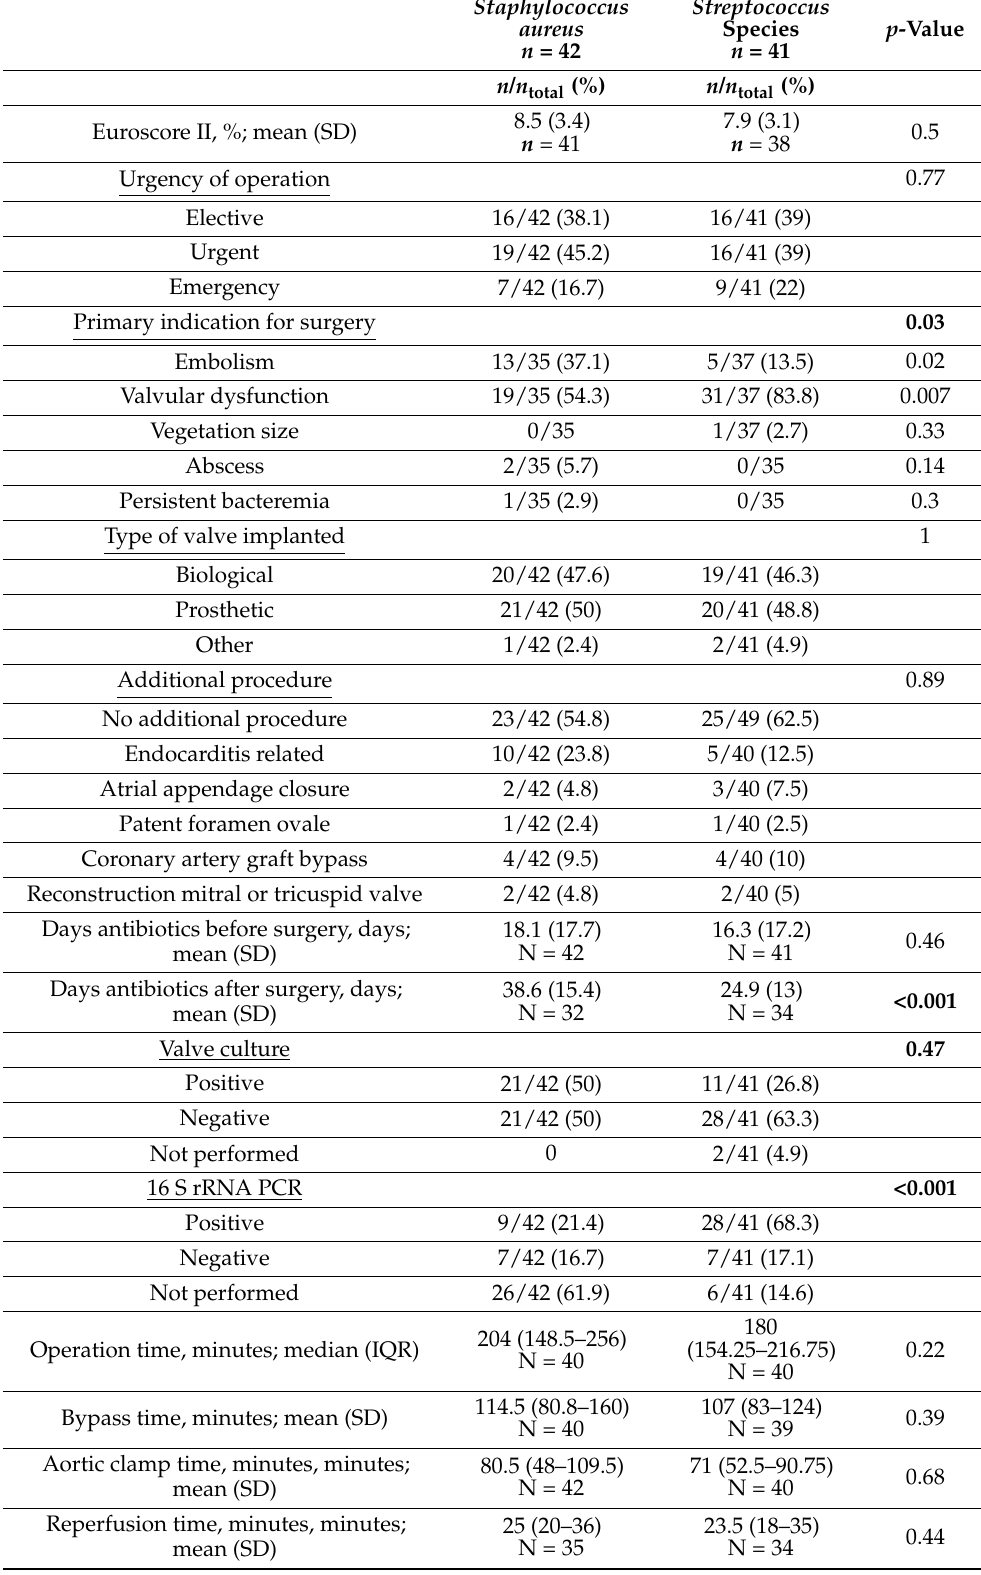
Table 2. Surgical procedures and postoperative outcome in patients with Staphylococcus aureus or Streptococcus spp.